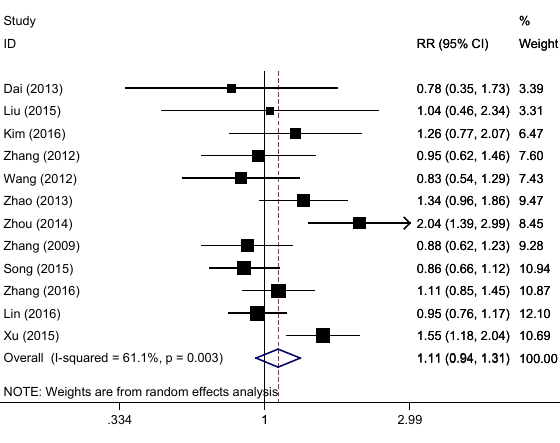
Figure 3: Forest of DCR of Pemetrexed versus Gefitinib as second- line treatment for advanced NSCLC.